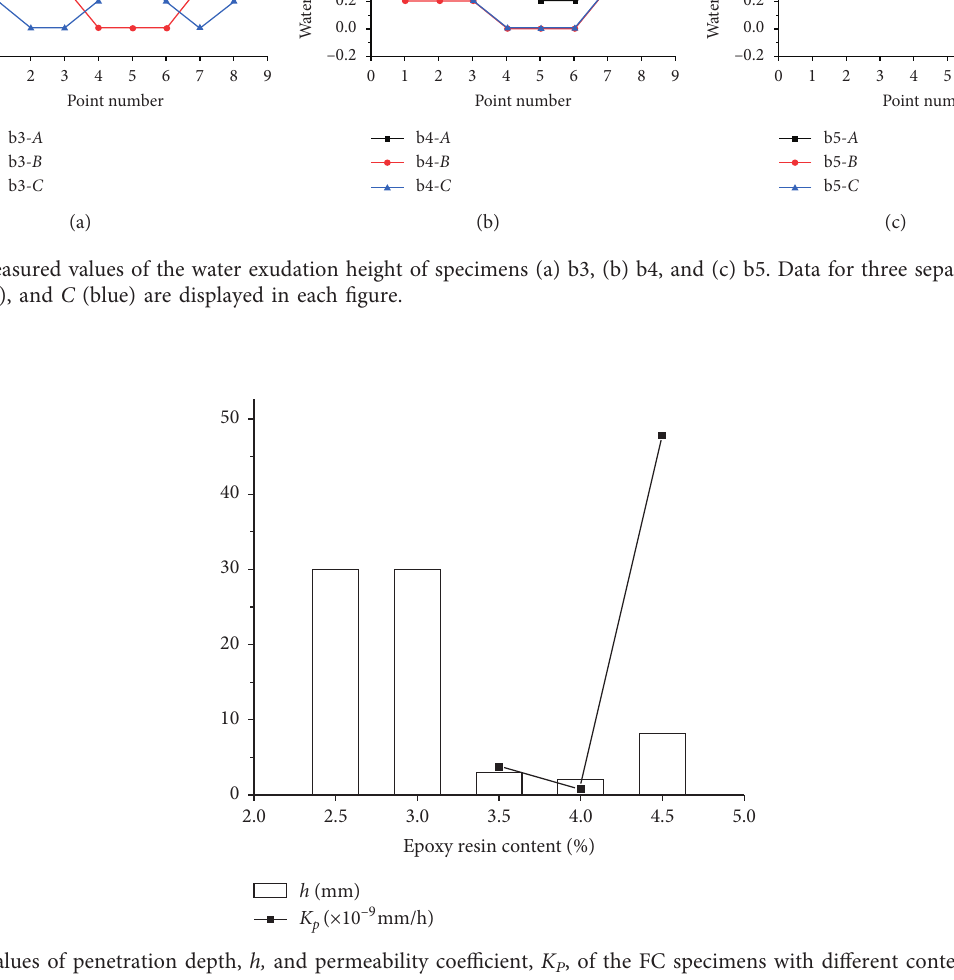
P , of the FC specimens with different contents EP